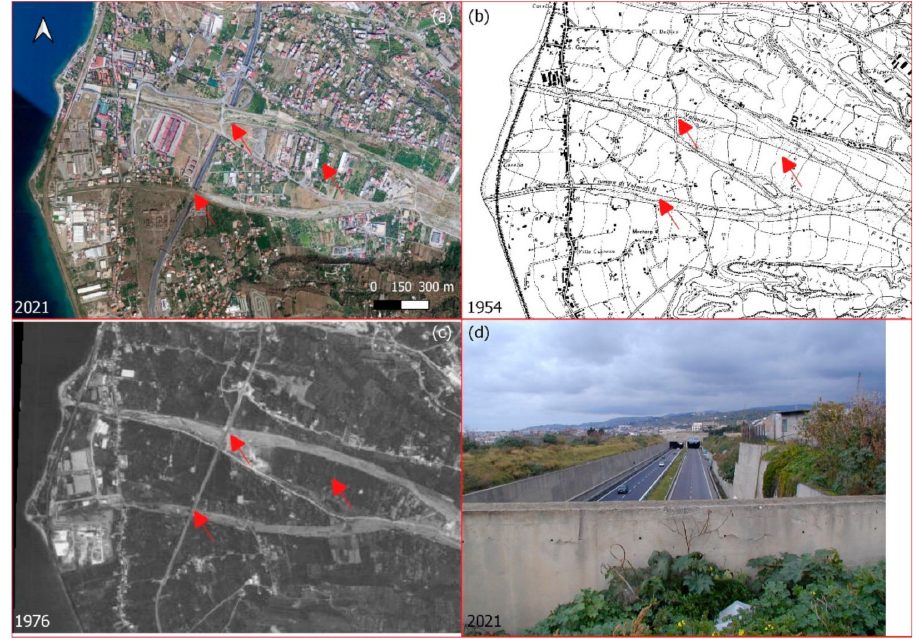
Figure 4. The Valanidi River. ( a ) An image from Google Earth from September 2021. ( b ) The CASMEZ cartography of 1954. ( c ) The aerial photogrammetry of 1976. ( d ) The view from Valanidi II toward Valanidi I. The arrows identify the current anthropized area downstream of the junction and the points where the rivers currently pass over the